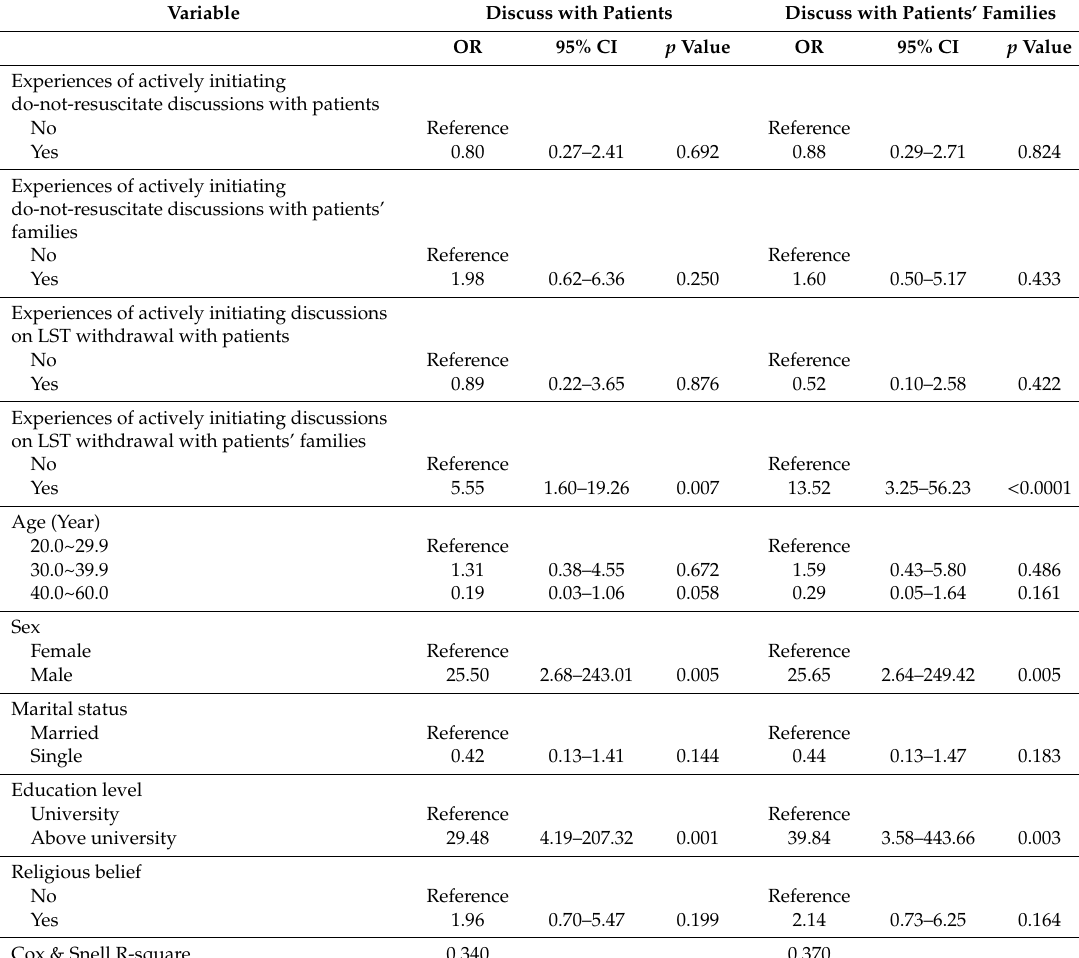
Table 4. Factors related to attitudes toward discussions of life-sustaining treatment (LST) withdrawal for terminally ill patients in the future. Variable Discuss with Patients Discuss with Patients’ Families OR 95% CI p Value OR 95% CI p